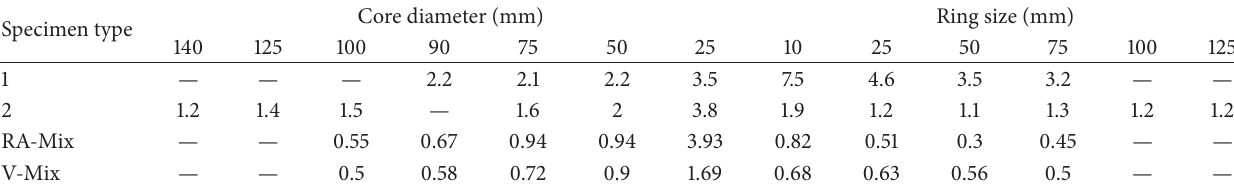
Table 4: Standard deviation for the core and ring analysis.